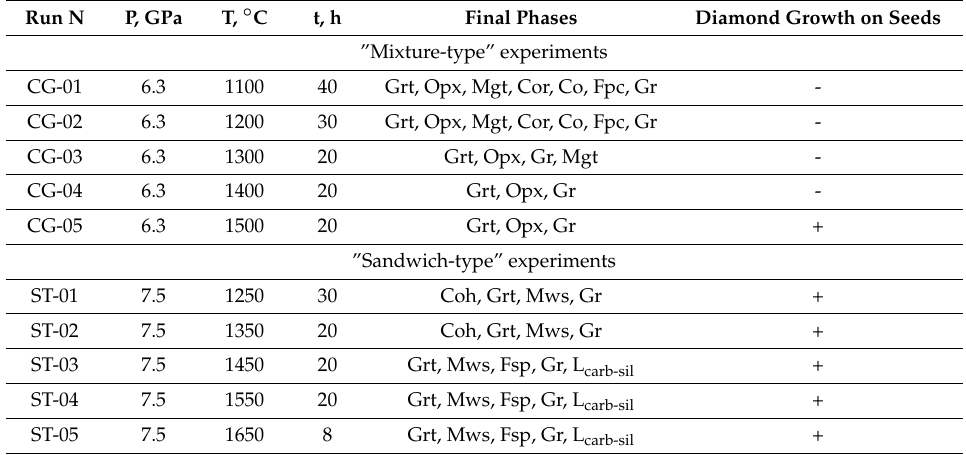
Table 3. Results of experiments in the carbide–oxide–carbonate systems at 6.3 and 7.5